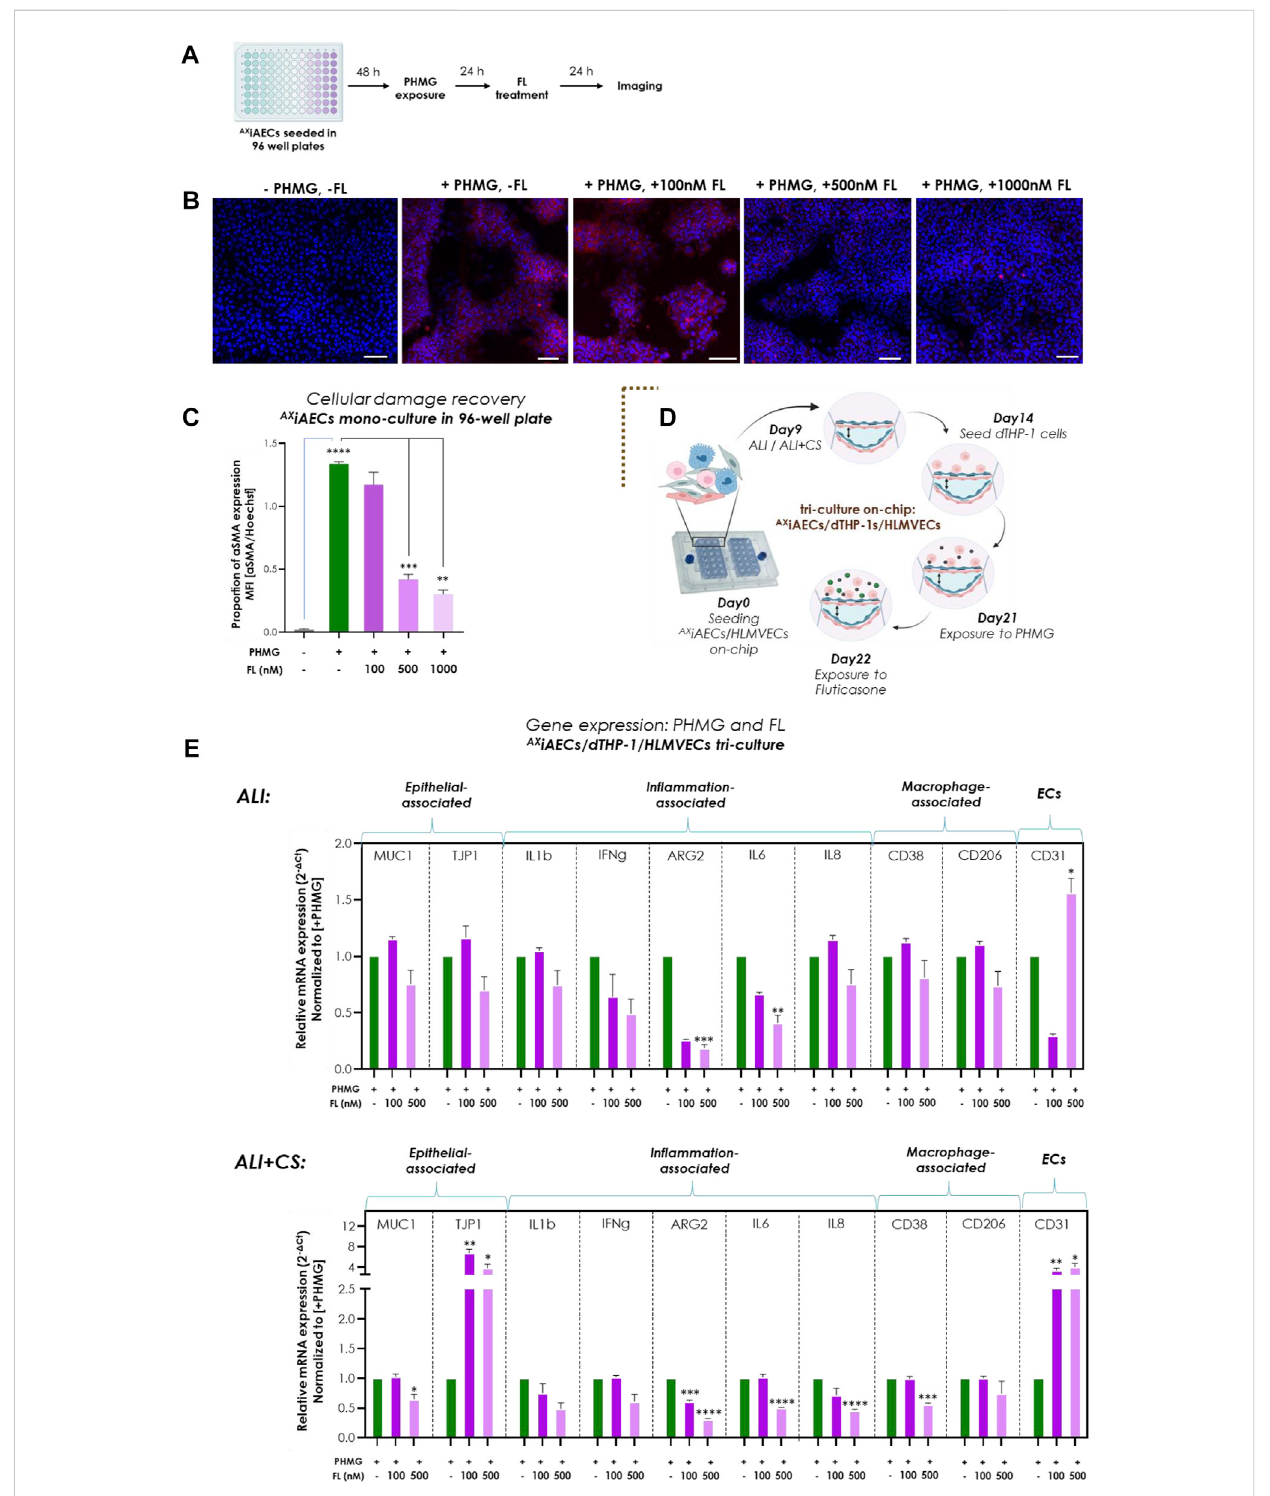
FIGURE 7 Inhaled Fluticasone reducedPHMG-inducedin fl ammationandEMT (A) Schematic timelineofthePHMGexposure andsubsequent FLtreatmenton AX iAECs mono-culture in96- well plates. (B) Representative stainingsof AX iAECs exposed to PHMG with/withoutFL treatmentunder ALI with α MA (in red) andHoechst(inblue).Scalebaris100 µm. (C) Themean fl uorescentintensity(MFI)wascalculatedandtheproprotionof α SMAexpressionwascalculated by normalizing with the nuclei intensity. PHMG exposed cells (+PHMG, -FL) was compared with healthy untreated controls (-PHMG, -FL) to check in fl ammation by PHMG. Next, PHMG exposed cells (+PHMG, -FL) were compared with PHMG and FL treated cells (+PHMG, +100nM/500nM/1000 nM FL) to check anti-in fl ammatory effect of FL. Region of interest (ROI or n = 6/conditions). Data are shown as mean ± SEM. (D) Brown dotted brackets representon-chipexperiments.TimelineandschematicforPHMGandFLtreatmentintri-cellculture( AX iAECs/d-THP1s/HLMVECs)on-chip. (E) Selected genes for epithelial cells, in fl ammation-associated, macrophage and endothelial cells were measured under both ALI and ALI + CS conditions on-chip. Signi fi cance associated with FL treated cells were estimated by comparing in fl amed cells (+PHMG, -FL) with 100 nM (+PHMG, +100 nM FL) and 500 nM (+PHMG,+500 nMFL)FLnebulizedcells(N=2,n=8).Dataareshownasmean±SEMnormalizedtoPHMGinducedbutwithoutsubsequentFL(+PHMG -FL)